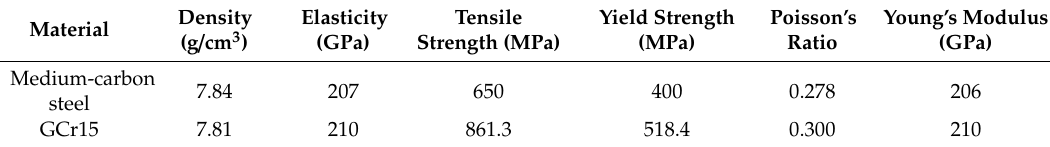
Figure 11. The schematic of the physical model. Table 6. The performance parameters of medium-carbon steel and GCr15.